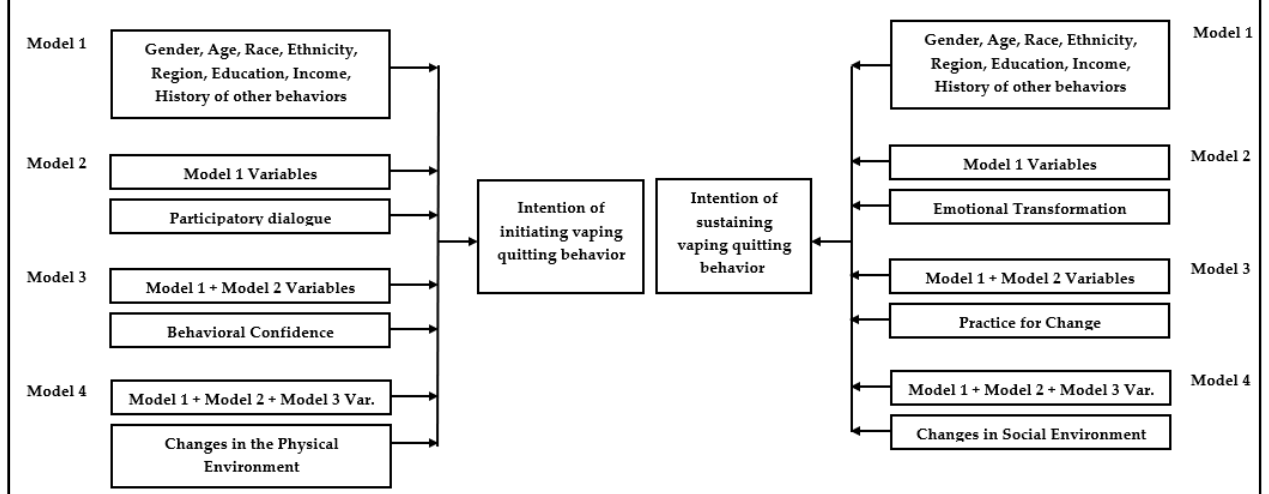
Figure 3. A flowchart detailing the model building process of the hierarchical regression.